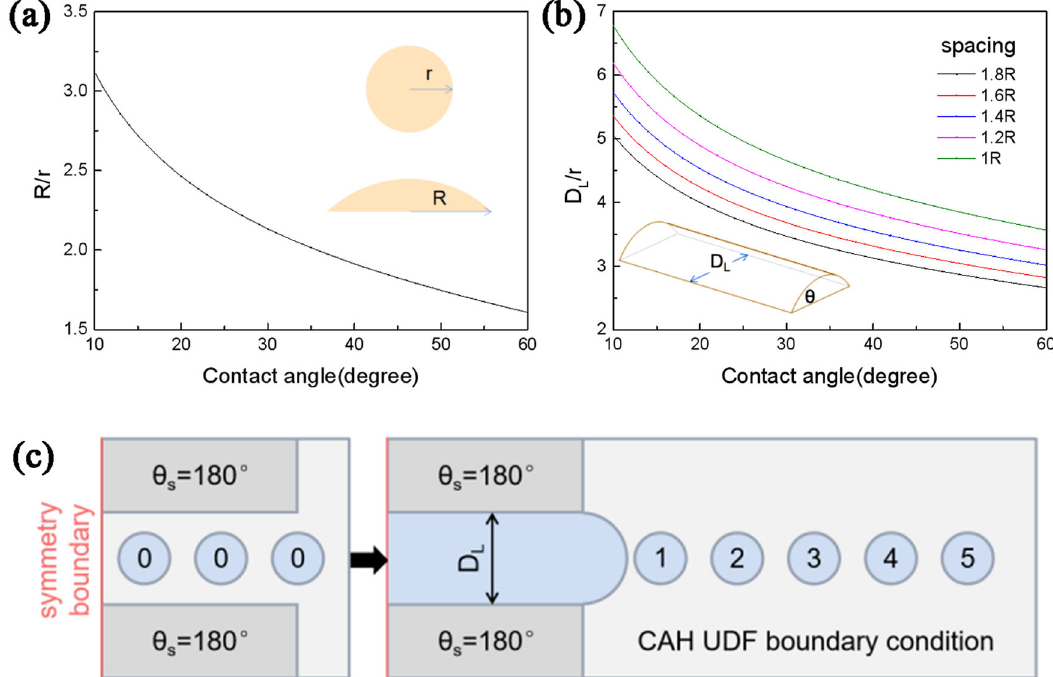
Fig. 6 Preparation of multi-droplet deposition simulation. a Scale ratio of deposited droplets to falling droplets with different static contact angles. b Width of a printed continuous line with different drop spacing and a static contact angle. c Schematic diagram of the method to avoid aggregation of droplets. In a R / r means the radius ratio between deposited droplets and falling droplets, and the ratio rationally decreases with increased contact angle. In b , D L is the width of the printed line, R and r are the radii of deposited droplets and falling droplets, and the fi gure shows that both larger drop spacing and larger contact angle induce thinner lines. c Is the top view of the initial settings to avoid aggregation of droplets, circles with the number 0 represent initial patched droplets, and regions with θ s = 180° are dewetting regions, the D L is set as the value in ( b